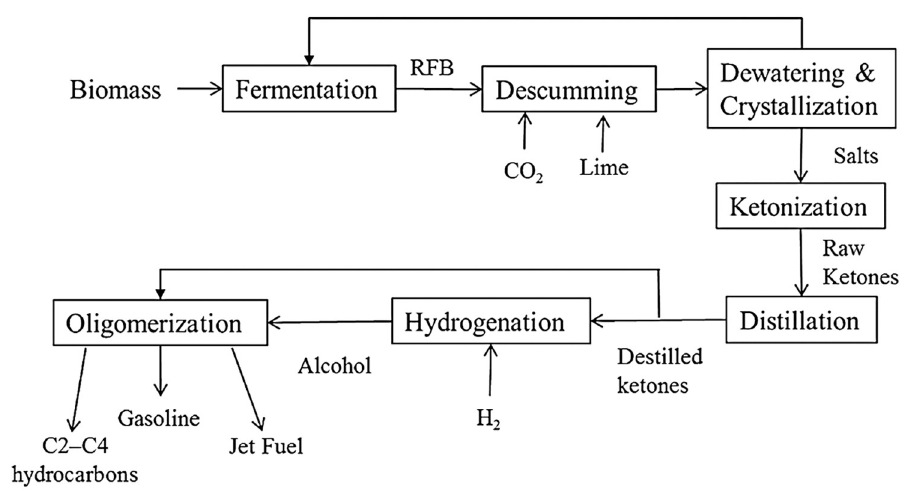
Fig 1. Simplified process block diagram of the MixAlco ™